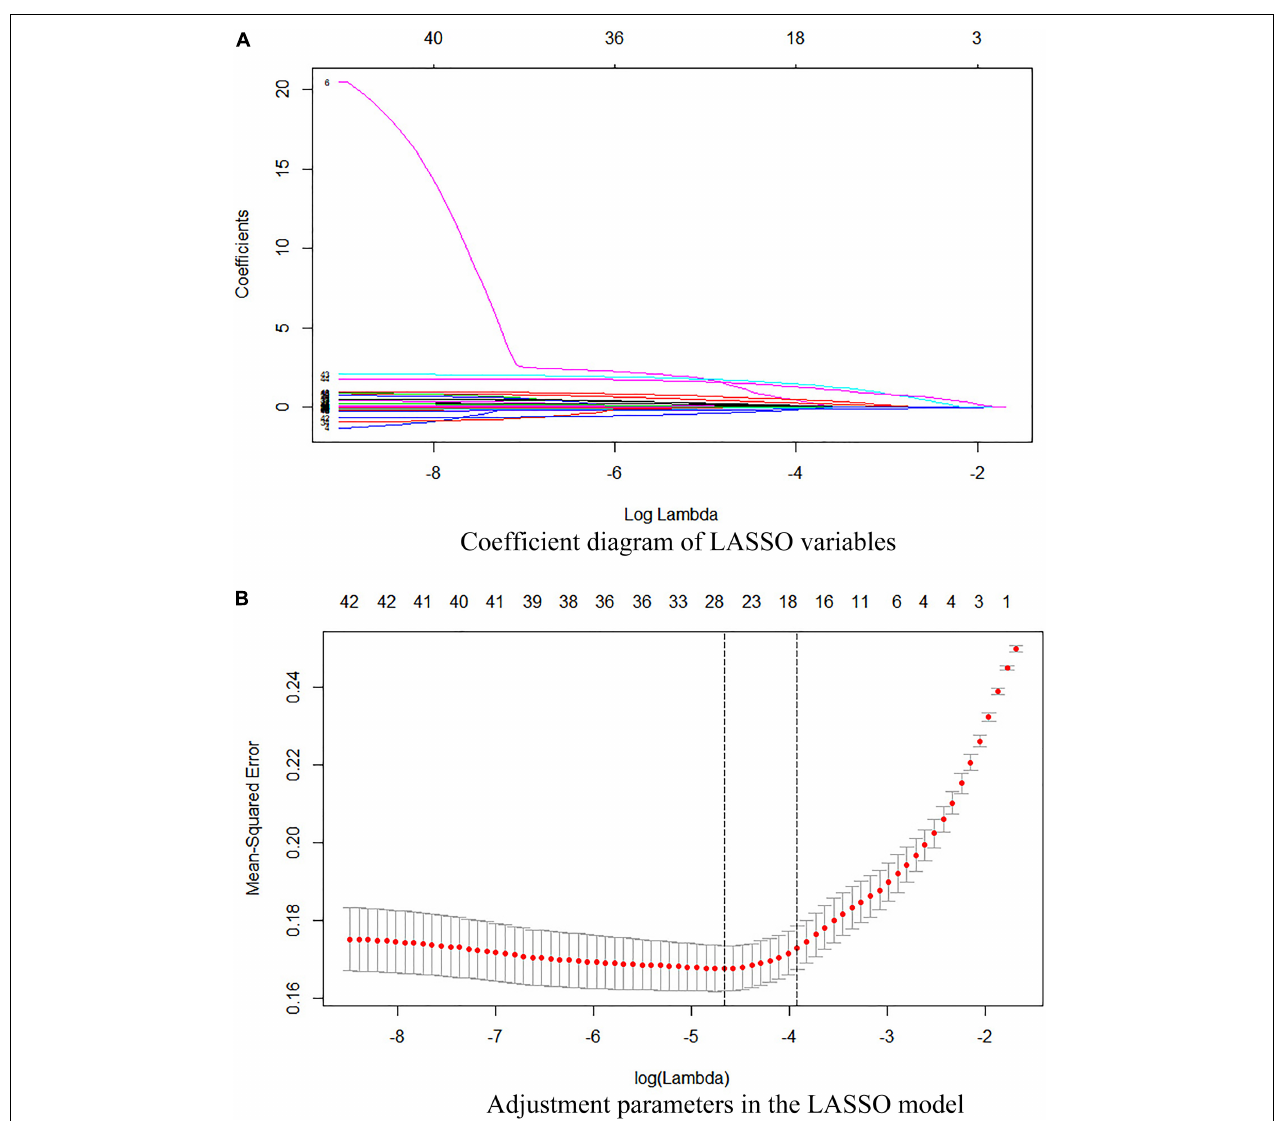
FIGURE 2 | (A) Coefficient diagram of the LASSO variables. Each curve in the figure represents the trajectory of the coefficient of an independent variable. The ordinate is the value of the coefficient. The lower abscissa, λ , is the parameter that controls the severity of the penalty. The upper abscissa is the number of non-zero coefficients in the model under the penalty parameter. (B) Adjustment parameters in the LASSO model. The λ is screened by 10-fold cross-validation. A dashed vertical line is drawn at 1 standard error (1-SE standard) of the minimum and maximum standards. λ .1se corresponds to a model that has a good performance with the fewest number of